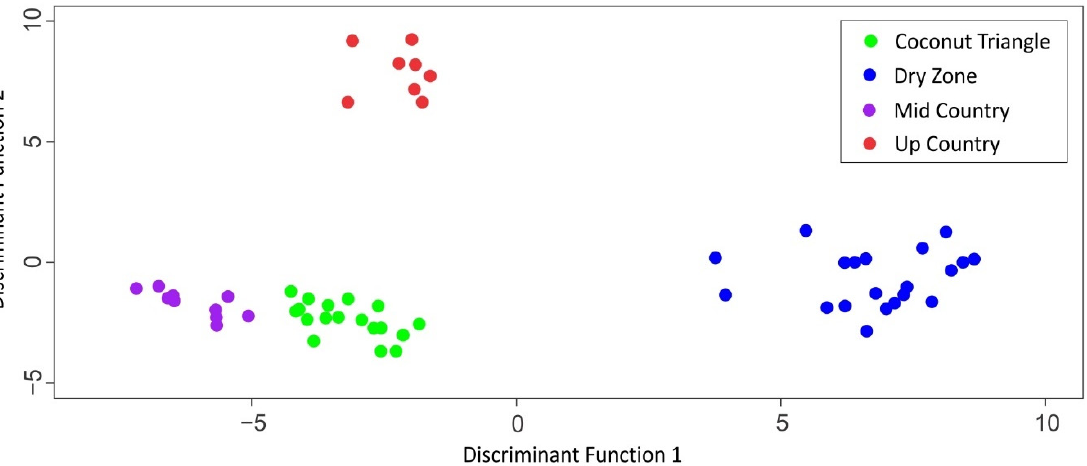
Figure 7. LDA of milk samples with both selected trace elements and stable isotope ratios to discriminate four agroclimatic zones.